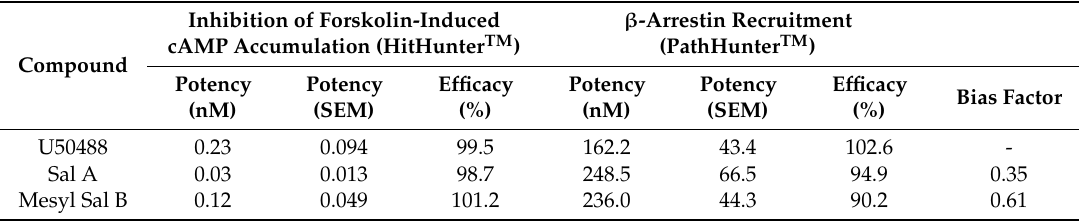
Figure 1. The chemical structures of ( a ) U50488, ( b ) Sal A and ( c ) Mesyl Sal B. 110 Table 1. The activity of U50488, Sal A, and Mesyl Sal B in the cyclic adenosine monophosphate (cAMP) and β -arrestin recruitment assays. 112